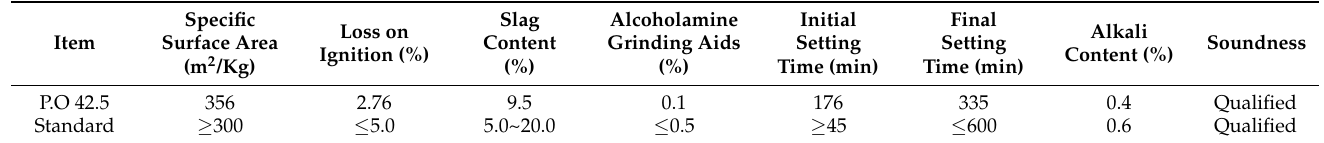
Table 1. Performance parameters of P.O 42.5 Portland cement.